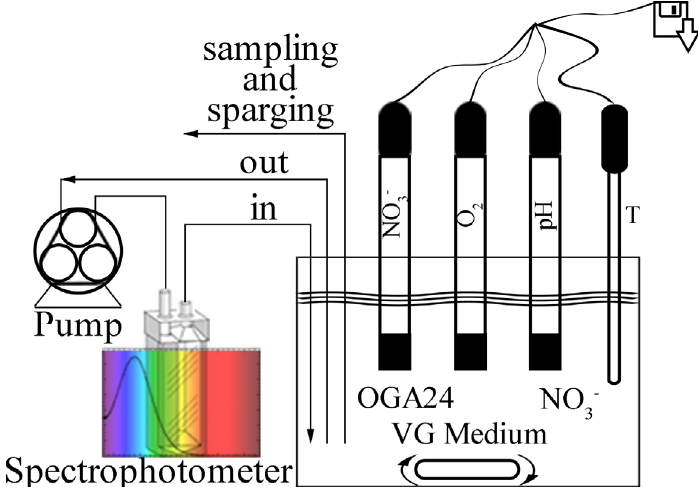
Figure 1. Skecth of the bioreactor used in